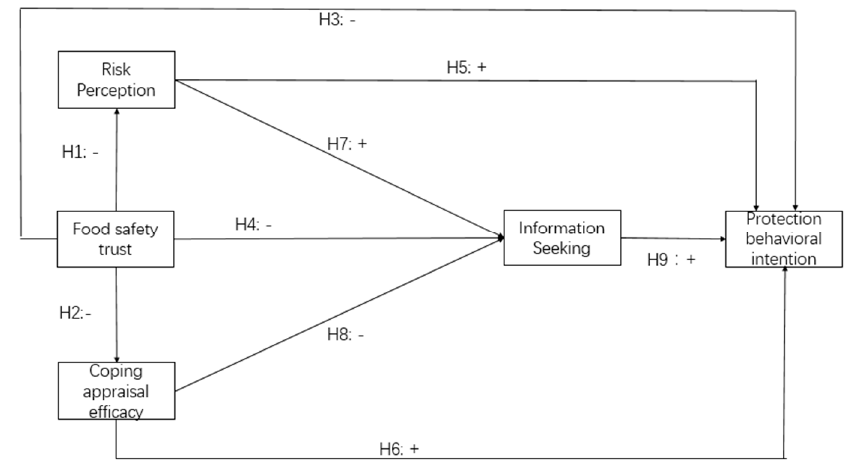
Figure 1. Conceptual model.